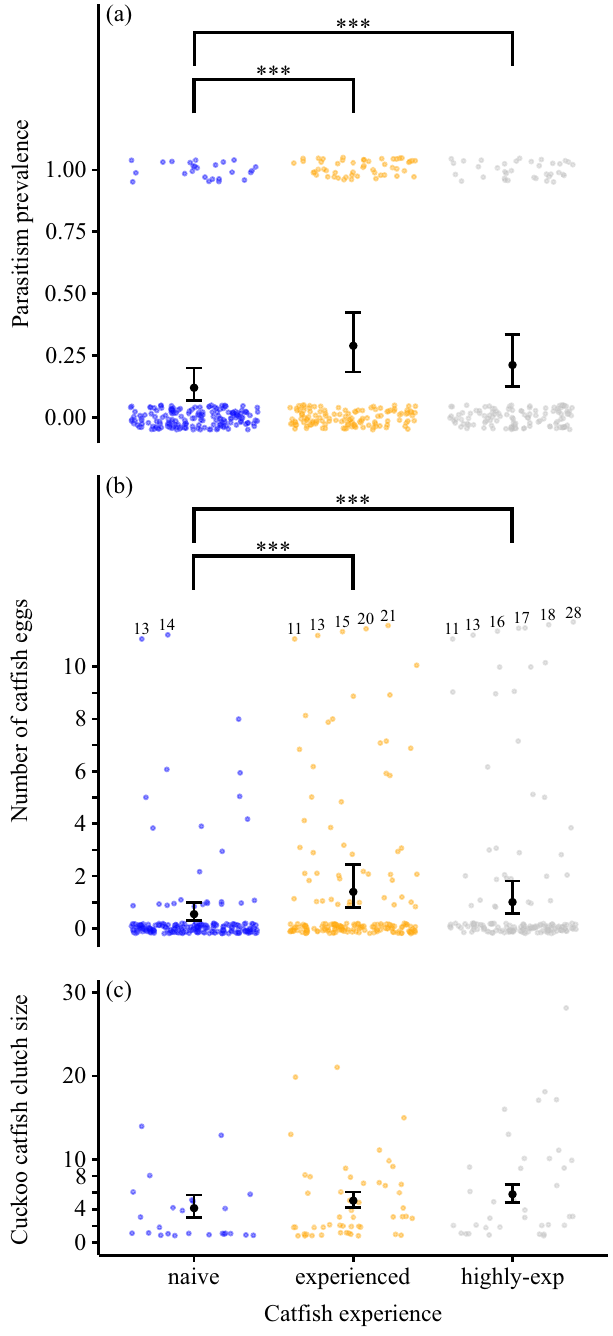
The mean number of cuckoo cat fi sh eggs calculated across all cichlid broods demonstrated the same pattern (Fig. 1b), with a mean (± S.E.) of only 0.46 (± 0.13) cat fi sh eggs across host clutches in the naïve cuckoo cat fi sh, but 1.42 (± 0.25) cat fi sh eggs and 1.63 (± 0.35) cat fi sh eggs in the experienced and highly experienced cat fi sh, respectively. The lower number of cat fi sh eggs in the naïve cat fi sh treatment was signi fi cantly different from the experienced and highly experienced cat fi sh (GLMM with negative binomial error, n = 509 host clutches: naïve vs.